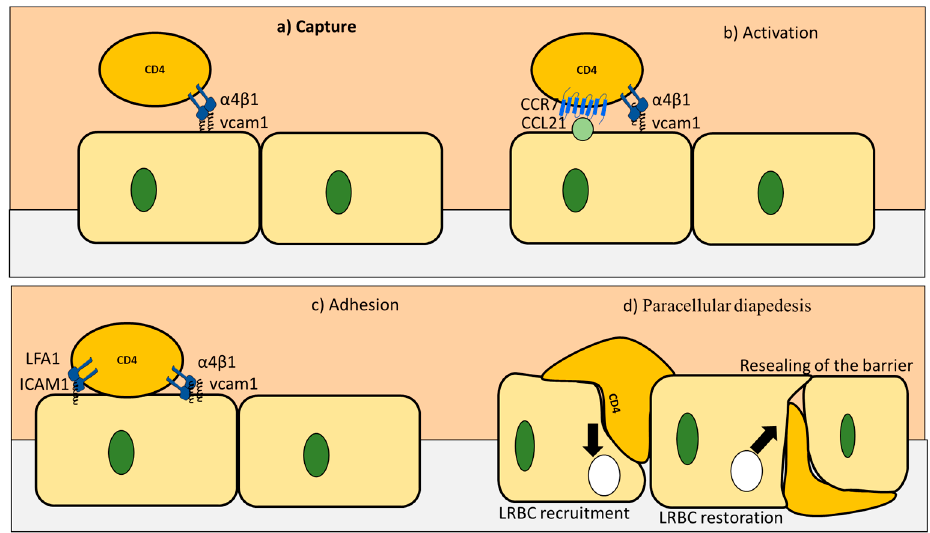
Figure 4. Four stages of extravasation of CD4+ T cells into the brain during health and disease. (a) In the capture stage, VCAM1 expressed on the endothelial cells binds to integrins expressed on CD4+ T cells. ( b ) After losing its speed, CD4+ T cells explore the surface of endothelial cells for ligands for their CCR7 receptor. ( c ) In the third stage known as adhesion, strong binds are formed using ICAM1 and VCAM1 from one side and LFA1 and α 4 β 1 from the CD4 + T cells side. ( d ) Finally, paracellular diapedesis takes place, with cadherin downregulated, PECAM1 upregulated, and LRBC formed to store membrane proteins that takes an active part in the process. At the end of the process, LRBC is resorted, and sealing of the barrier takes place. Adapted from [35]. Copyright Springer, 2006. Table 3. Various stages of CD4+ T cells infiltration of the BBB.